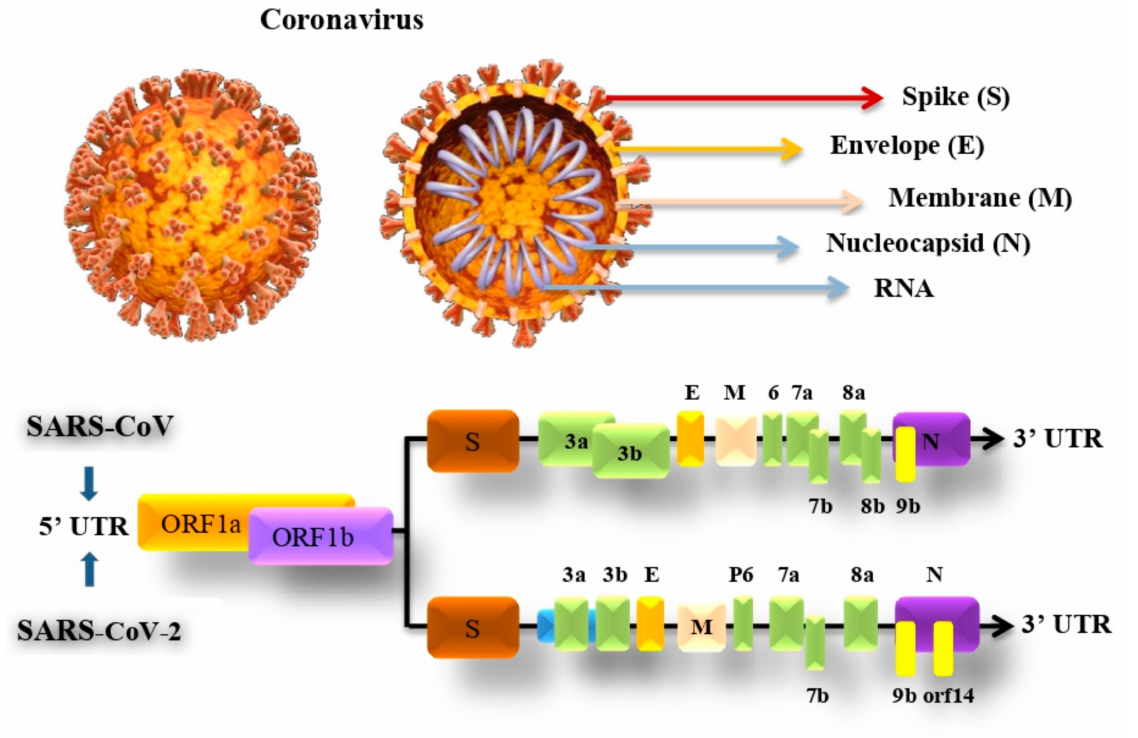
Figure 2. SARS-CoV and SARS-CoV-2 genomic structure and